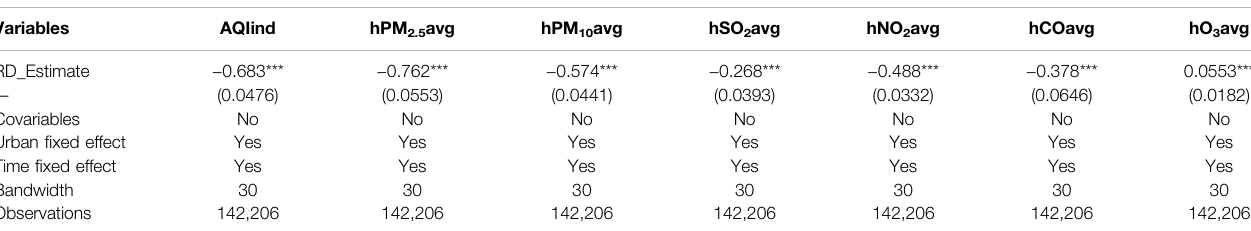
TABLE 3 | Results of the sharp RD design for AQI and six pollutant